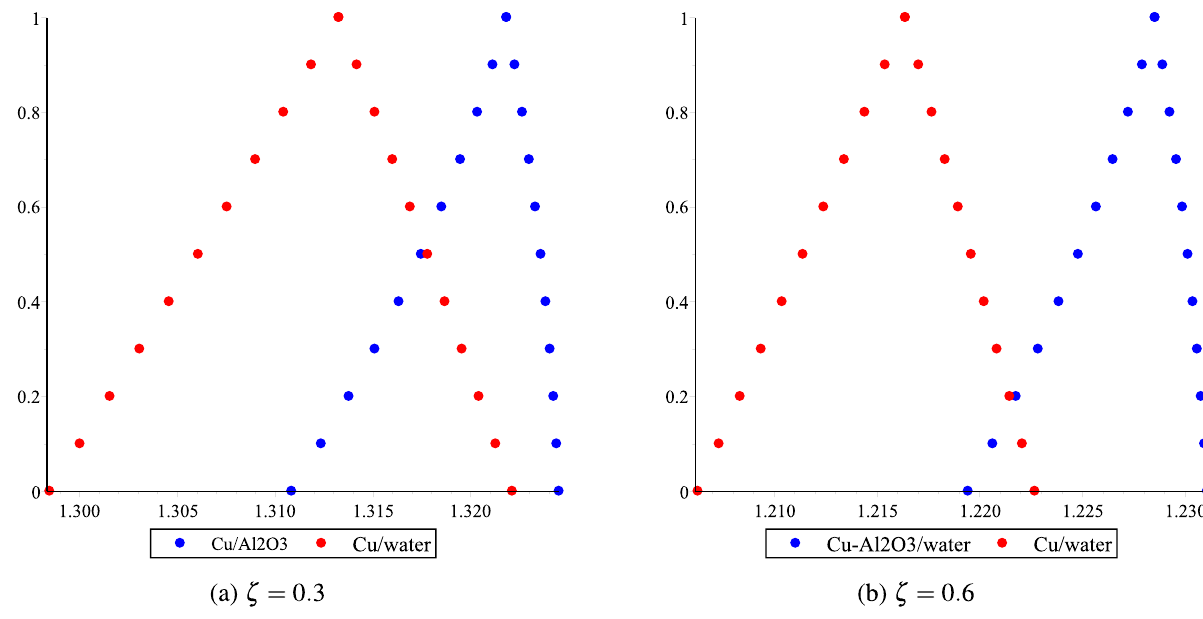
Figure 15. Effect of φ = [ 0%, 3%, 5% ] for Cu-H 2 O and Cu-Al 2 O 3 /H 2 O on fluid temperature distribution bound υ(α , δ , ζ) in ω > 0 with.